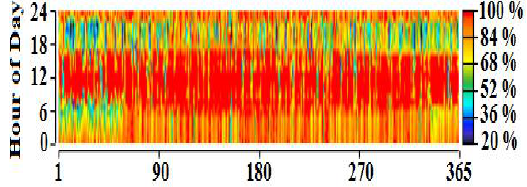
Figure 26. SOC of battery for case IV (Ba/Bi/H/S).